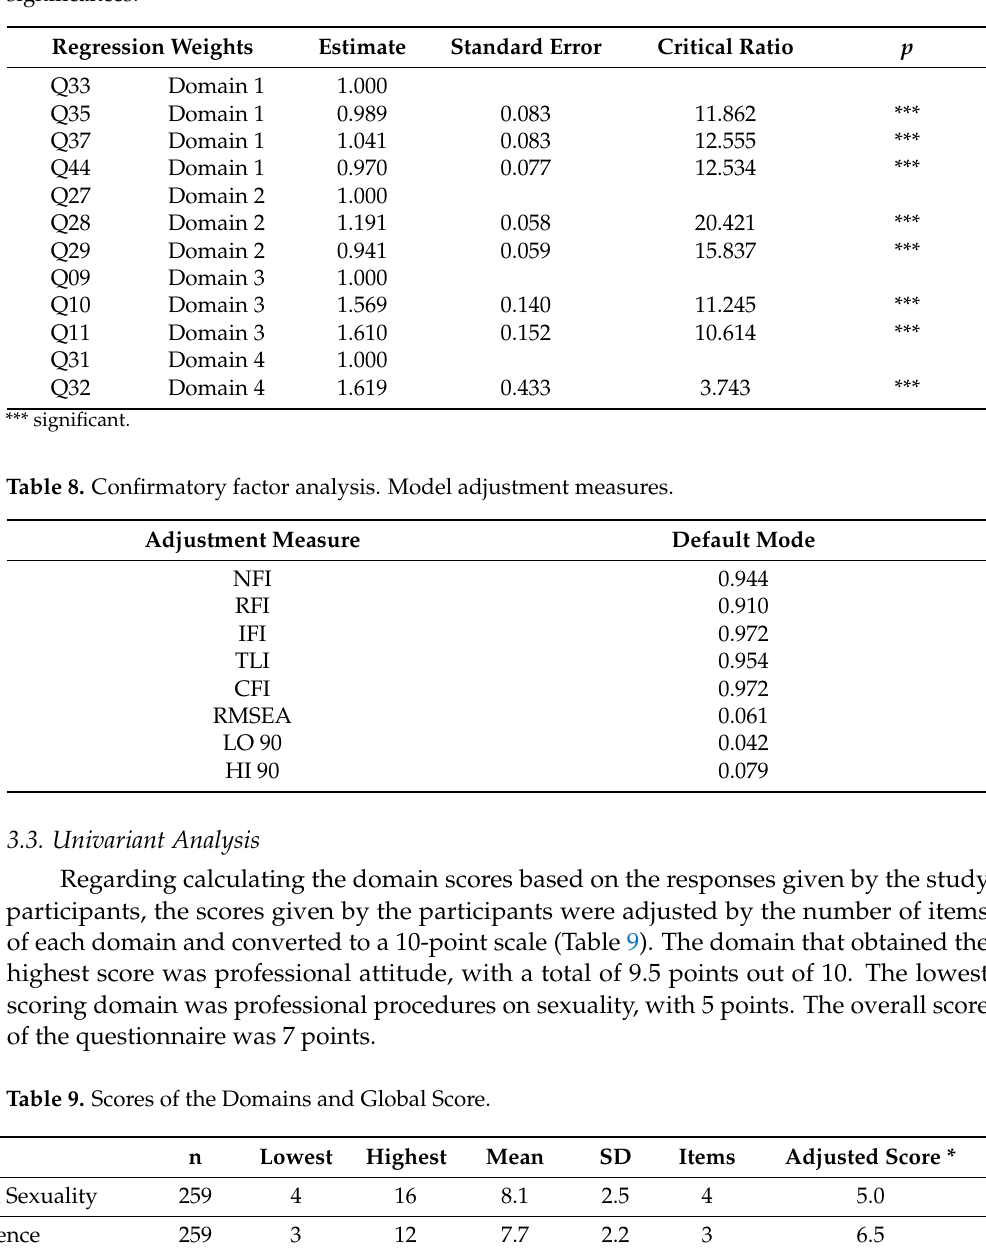
Table 7. Confirmatory factor analysis. Regression Weights, standard errors, critical ratios, and significances.